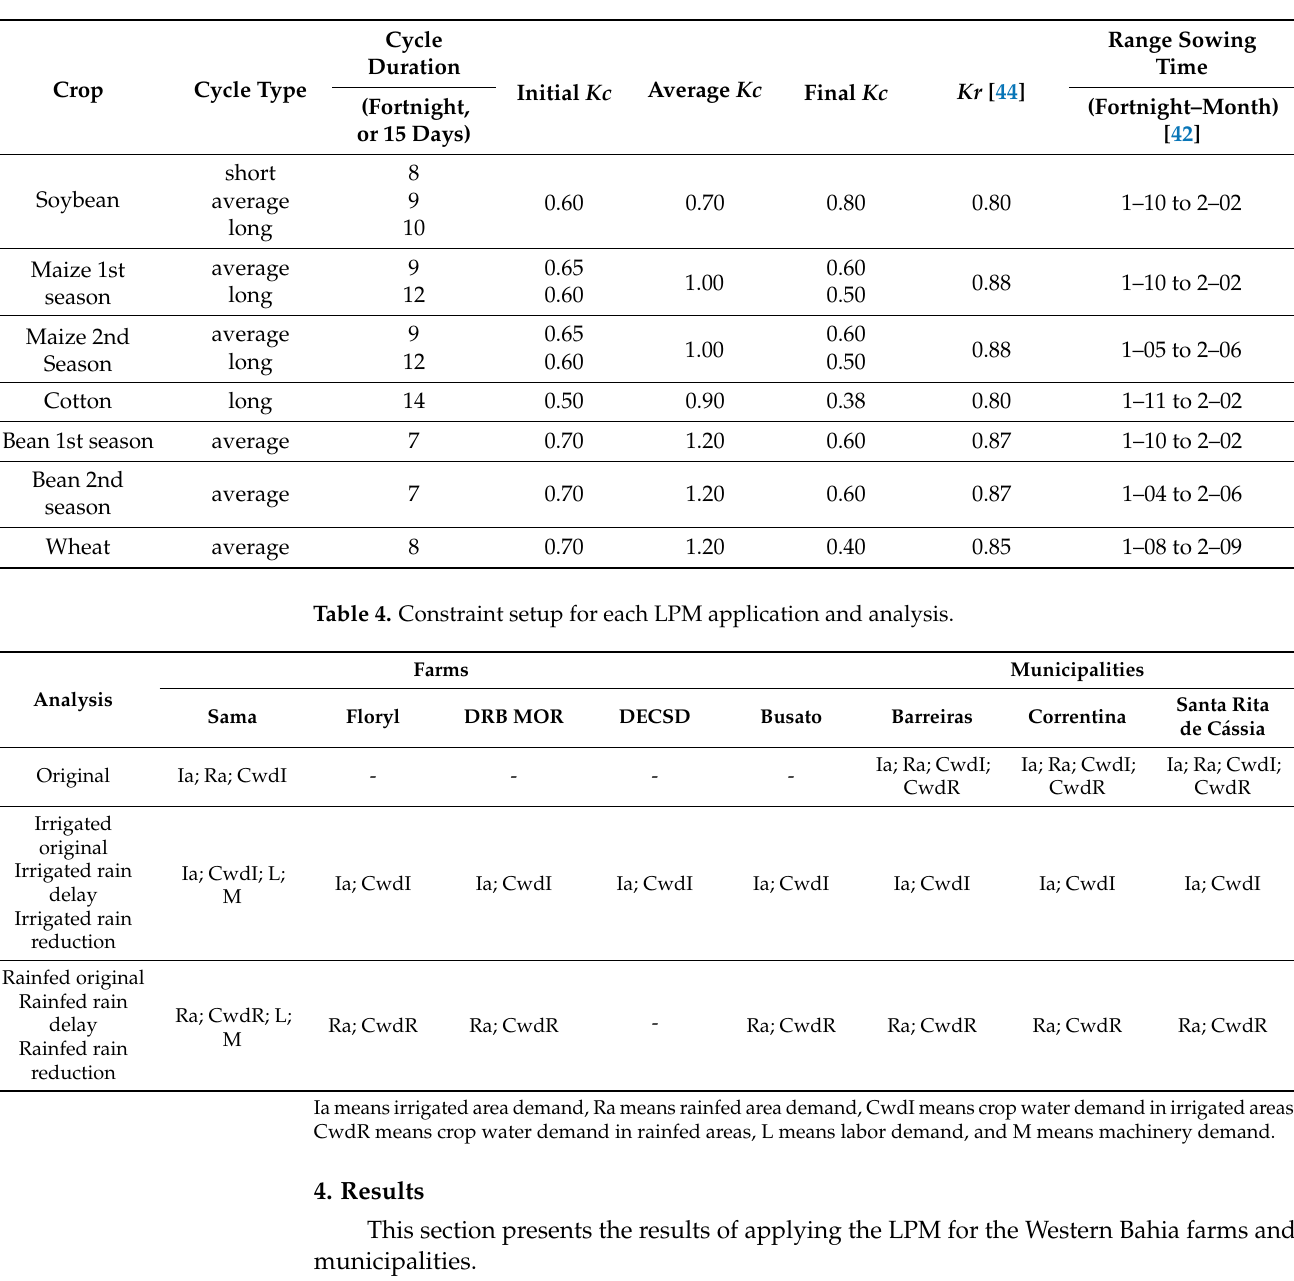
Table 3. Crop, cycle type, duration Kc , Kr , and ranging sowing time.